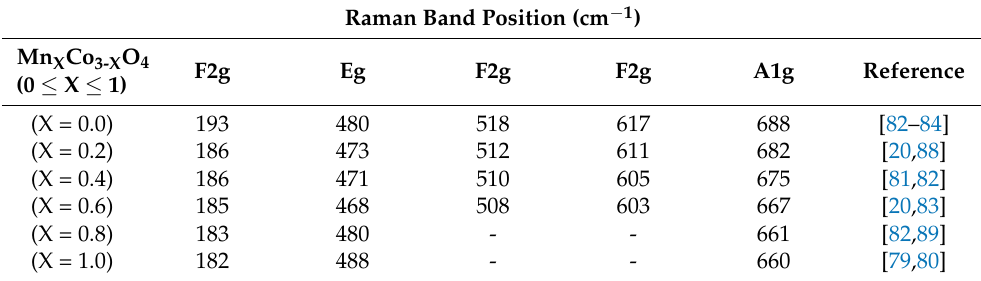
Figure 8. Raman spectra for all Mn X Co 3-X O 4 (0 ≤ X ≤ 1) samples. Table 3. Raman active band positions for Mn X Co 3-X O 4 (0 ≤ X ≤ 1) samples and their comparison with the literature.